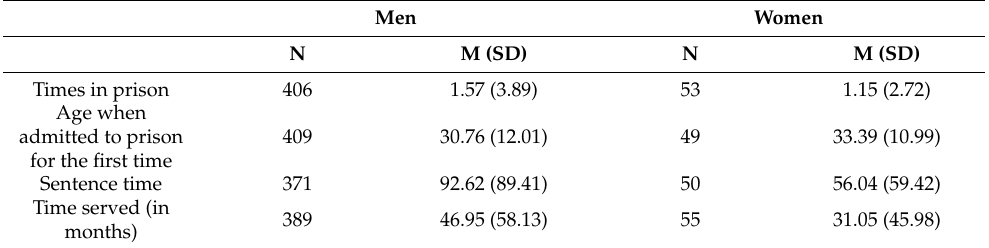
Table 4. Descriptive statistics of the quantitative criminal variables according to